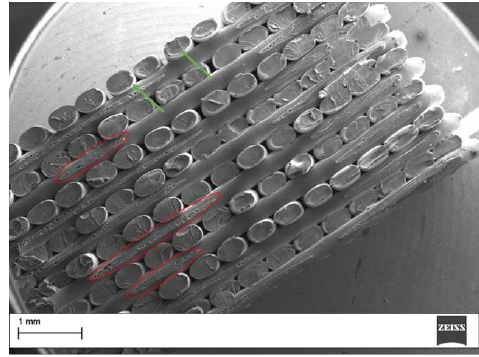
Figure 9. Fracture surface morphology for a tensile sample (tan resin). Red ellipse highlights the adhesive failure on the transverse rasters. The green arrow highlights the yielded longitudinal rasters.